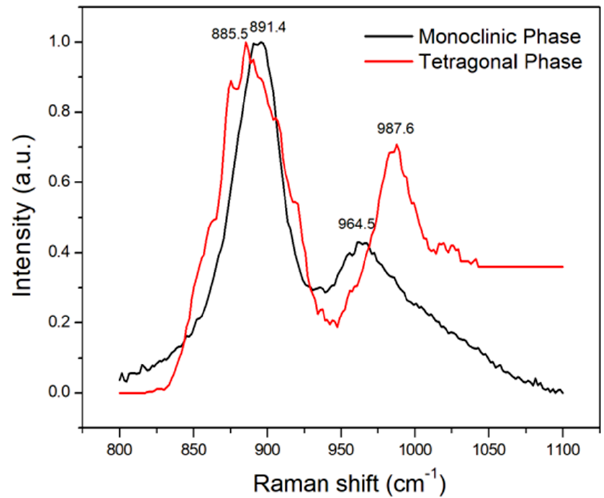
Figure 3. Raman spectra of the monoclinic phase single-crystalline fiber and tetragonal phase single-crystalline fiber. The double peaks indicate the existence of deuterium in the crystals.